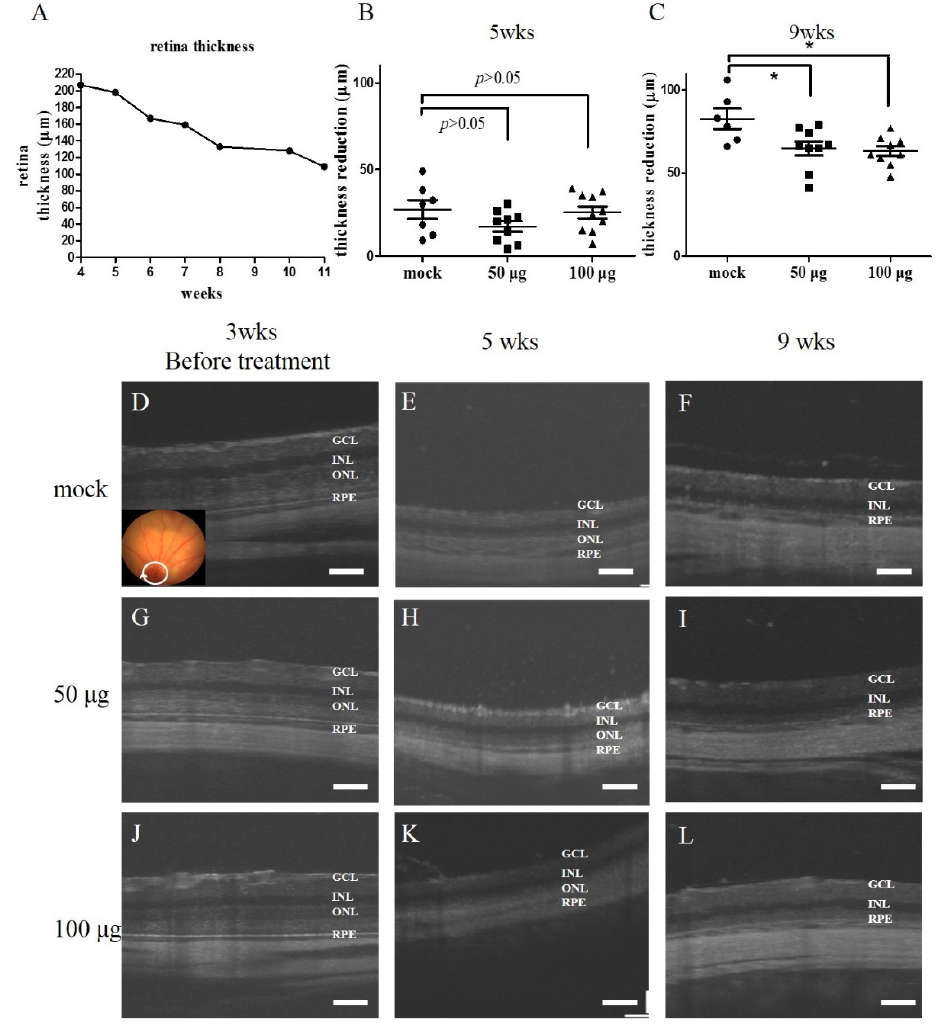
Figure 4. The rescue of the progressive retina degeneration after mitochondrial transplantation in RCS rats. ( A ) one of RCS rat retina thickness continuous recording by OCT from 4 to 11 weeks of age. The losses of the retina thickness at 5 weeks (wks) of age ( B ), and at 9 weeks of age ( C ) were compared between the mock-treated control and the mitochondria-treated groups (50 µ g and 100 µ g). The value of thickness reduction was the reduced length ( µ m) of the retina relative to the individually measured retina thickness at 3 weeks of age. * p < 0.05. ( D – L ) Representative OCT images of the control group and mitochondria-treated group of the rats at 3, 5, and 9 weeks of age. Scale bar in panel ( D – L ), 100 µ m. GCL: ganglion cell layer; INL: inner nuclear layer; ONL: outer nuclear layer; RPE: retinal pigment epithelium.